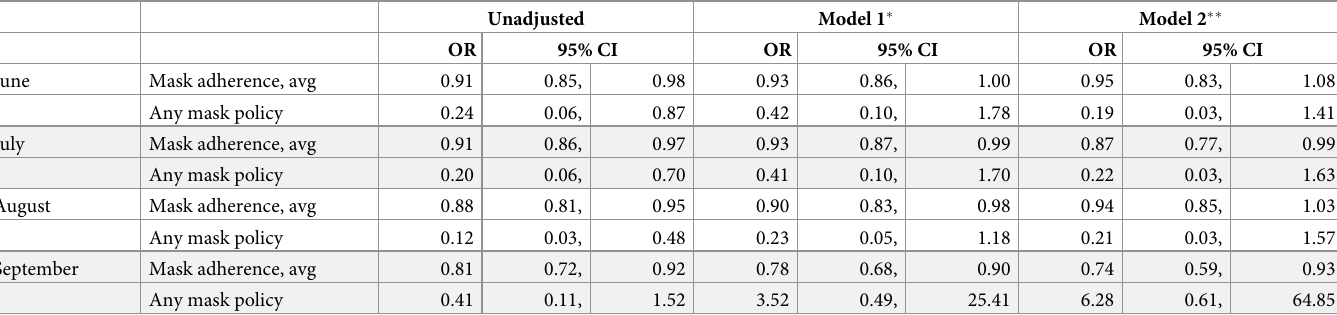
Table 3. State-level odds ratios and 95% confidence intervals (CI) for high versus lower COVID-19 rates in the subsequent